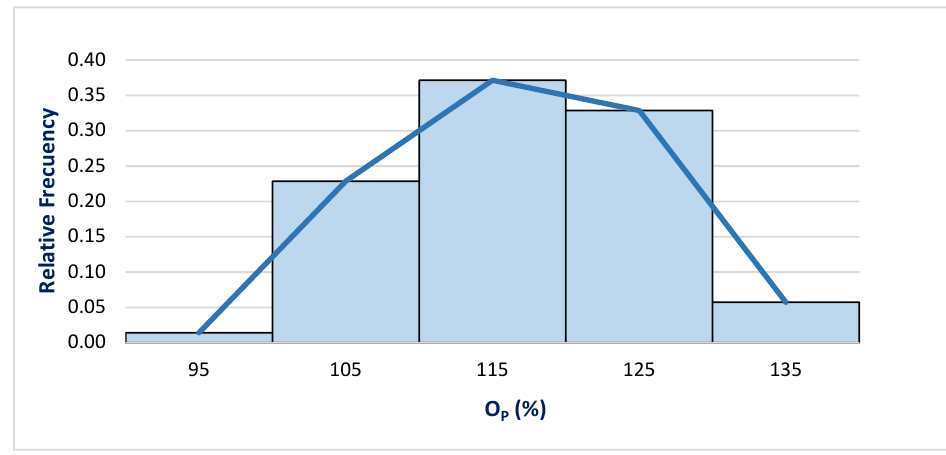
. Figure 2. Histogram of the index Figure 2. Histogram of the index O P . 𝑂𝑂 𝑃𝑃 Regarding the index (kWp/Ha), which represents the density of land use or the quotient between the installed peak power (kWp) and the area dedicated to the PV plant 𝐷𝐷 𝑃𝑃𝑃𝑃 (Ha), its histogram (Figure 3) shows that the most representative value of this index (with 51.42% of the PV plants) is between 400 and 600 kWp/Ha, followed by the 600–800 kWp/Ha class with the 15.71% of the cases. Likewise, it is observed that, in general terms and with the exception of the 1200–1400 kWp/Ha class, the relative frequencies of the clas- ses considered decrease as the index values move away from these more frequent classes. In this way, the minimum relative frequency is recorded for the classes in which the ex- treme values of the index are included, that is, for the classes 0–200 kWp/Ha and 1400– 1600 kWp/Ha, with 1.43% facilities in both cases.